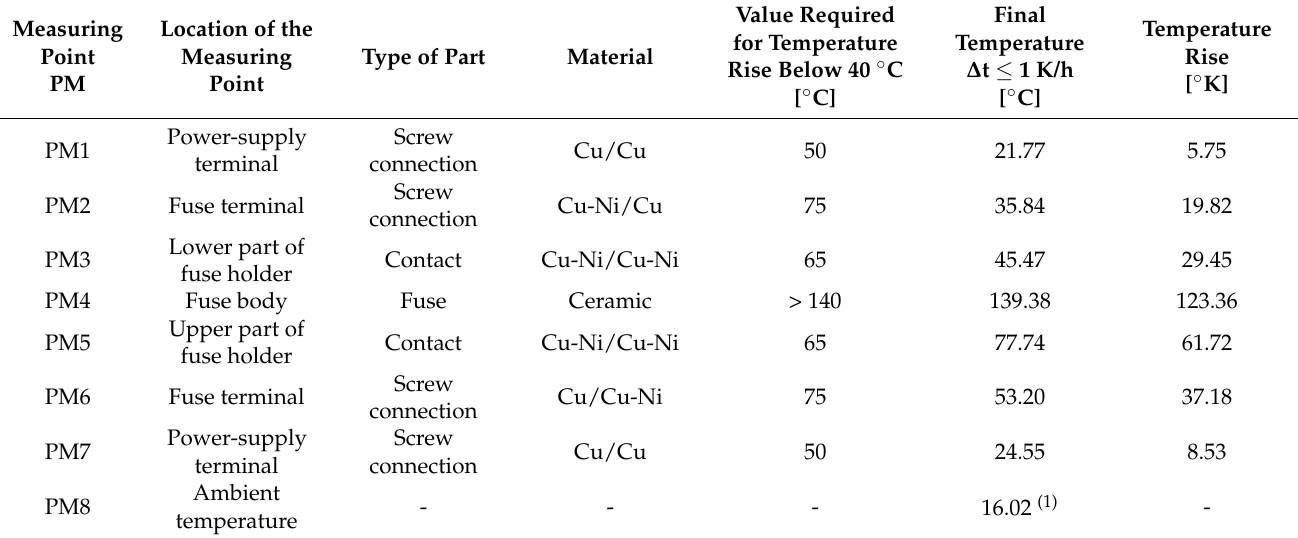
Table 3. Values obtained during temperature-rise experiments on 63 A fuse.